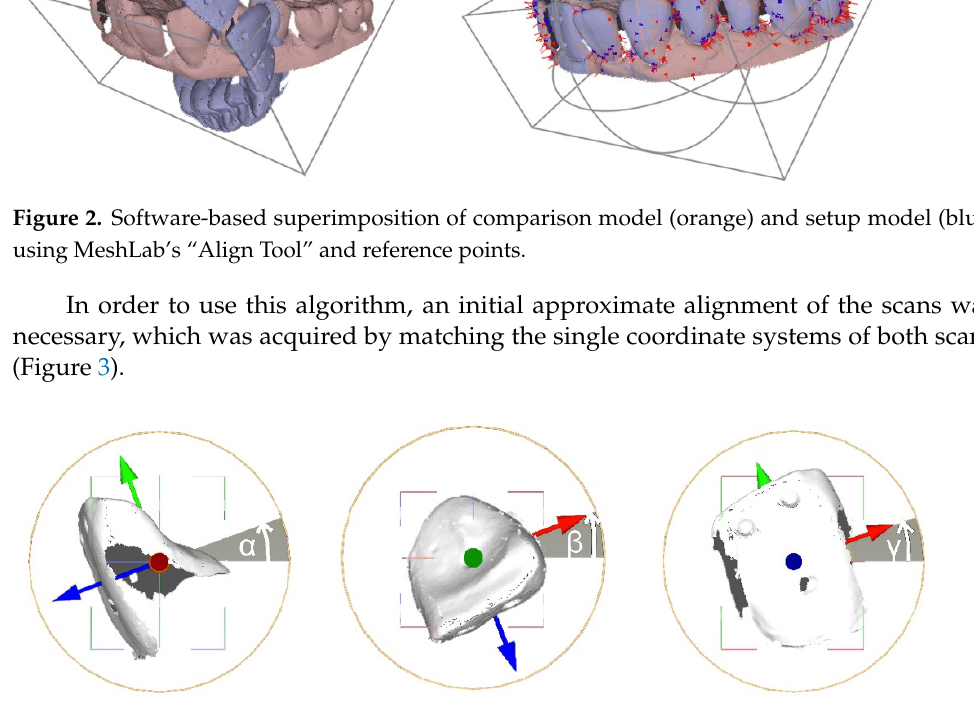
Table 1. Descriptive and inferential statistics of 1 mm translational vestibular ( Z -axis) movement of tooth 11 and 15° mesial rotation ( Y -axis) of tooth 23.